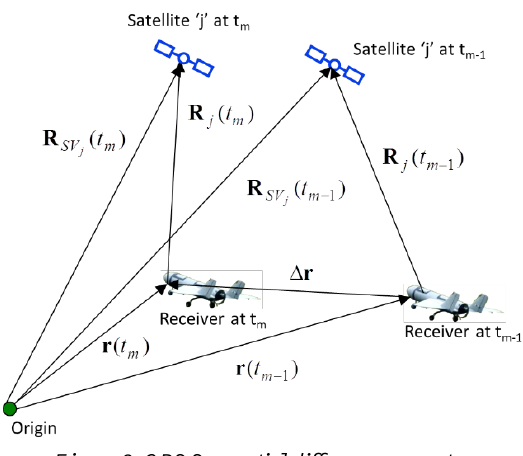
Figure 8. GPS Sequential difference geometry.